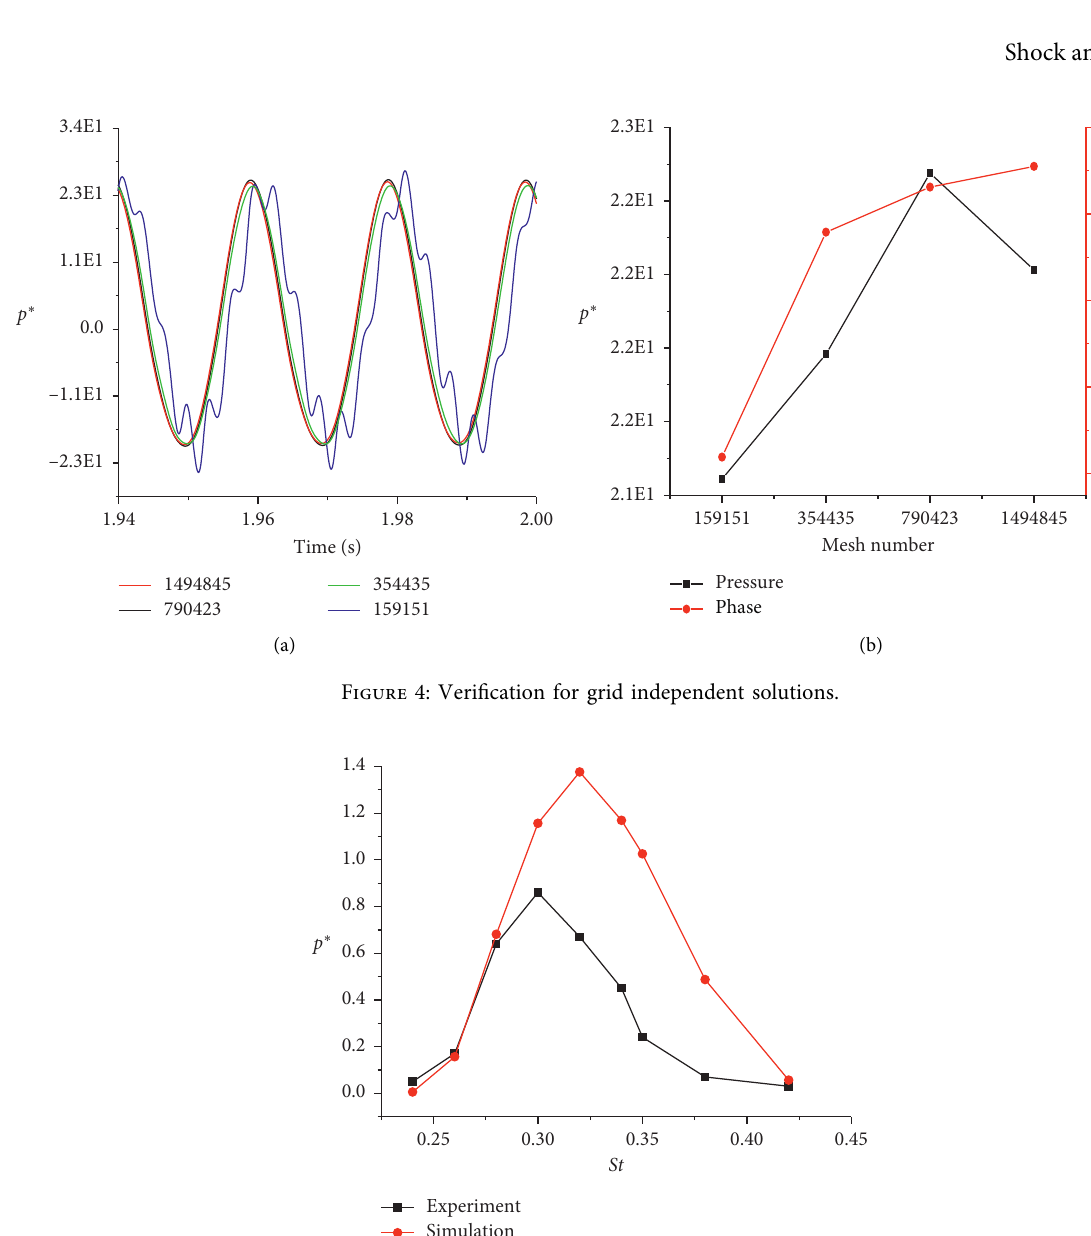
Figure 5: Comparison between Ziada and Shine [11] results and current simulation results.